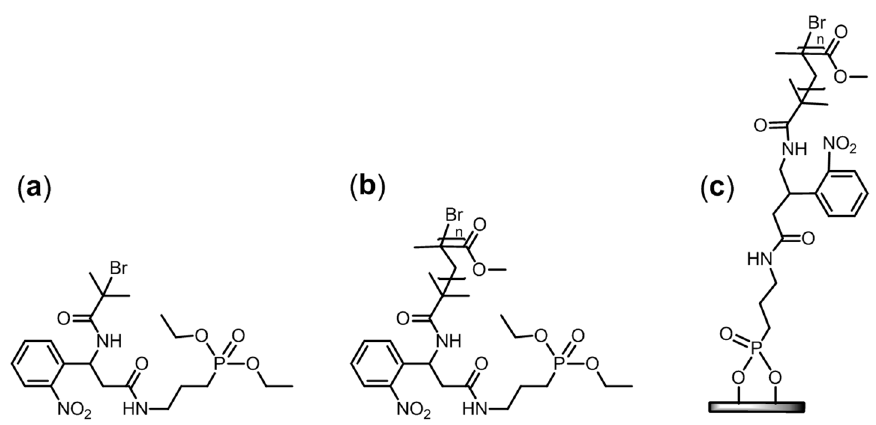
Figure 4. Molecular structures of the three PCI-based materials investigated: ( a ) photocleavable initiator (PCI), ( b ) model PCI-initiated PMMA, and ( c ) PCI-initiated PMMA brushes on Ti.